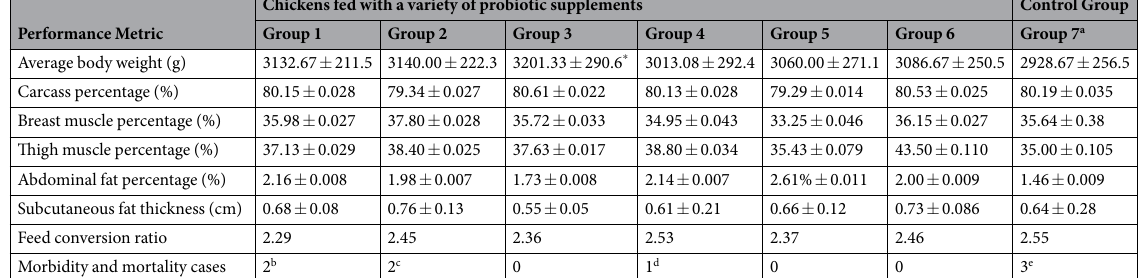
Table 1. Growth and meat production at 74 days of age of Qingjiaoma chickens given different probiotic- supplemented fermented feed. Asterisk ( * ) represents the significant difference of average body weight of Qingjiaoma chickens between Group 3 and the control group Group 7 ( P value = 0.0055). a Group 7 is the negative control group of chickens were fed without any probiotic supplement. b One bird in Group 1 was crushed by misplaced feed utensils at Day 1. c One bird in Group 2 fell from the cage and hurt its leg at 5 days of age. To control the experimental conditions, this bird was eliminated from our analysis. d One bird was eliminated from this group due to a wry neck caused by the improper subcutaneous injection of Bird Flu vaccine, to control the experimental condition this bird was eliminated for our analysis. e Two birds in the control group were eliminated by debeaking stress, which induced a very weak capability of food